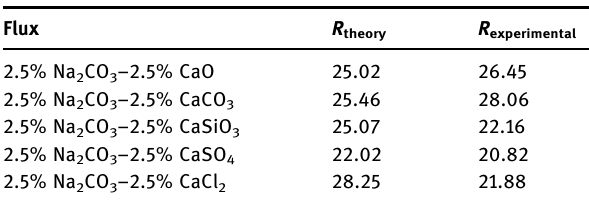
Table 3: Comparison of actual reactivity index and theoretical reactivity